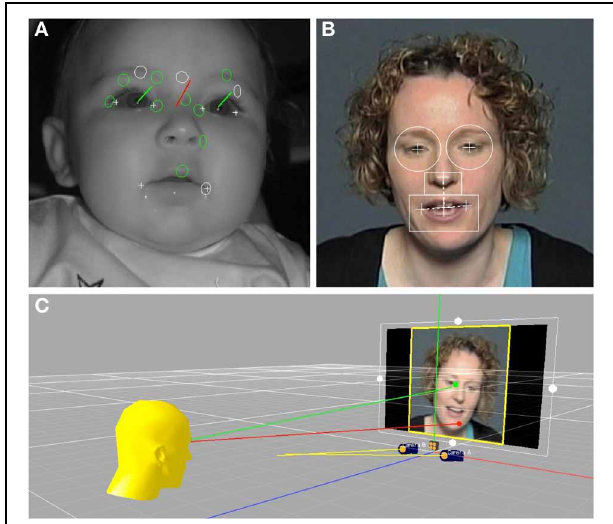
Figure 1 . Facial features were found to move over a wider range for the ID than AD speech videos, which corresponds with other work showing exaggerated visual prosodic head movements in ID speech (Smith and Strader, under review). For the left and right eyes, circular regions were defined (5 ◦ visual angle in diameter), that were centered on the pupil of each eye. The mouth ROI was defined by a rectangle (10 ◦ × 5 ◦ visual angle) that was horizon- tally centered on a bisection point on a line between the left and right corners of the mouth. The top edge of the mouth ROI was vertically aligned with a bisection point between the mouth cen- ter point and the tip of the nose. The nose ROI was a rectangle (4 ◦ × 2.5 ◦ ) with a bottom edge that abutted the top of the mouth ROI, which was horizontally centered on the nose tip point.